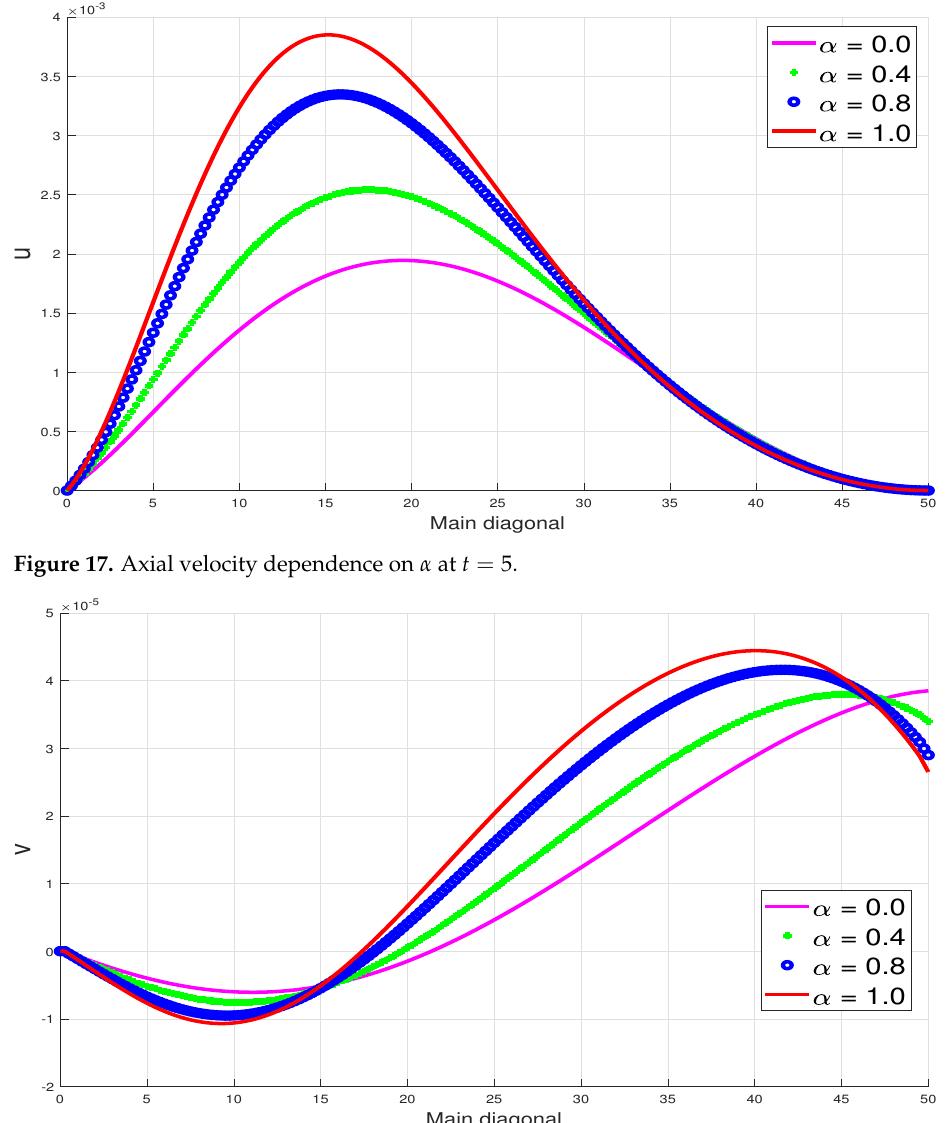
Figure 18. Transverse velocity dependence on α at t =